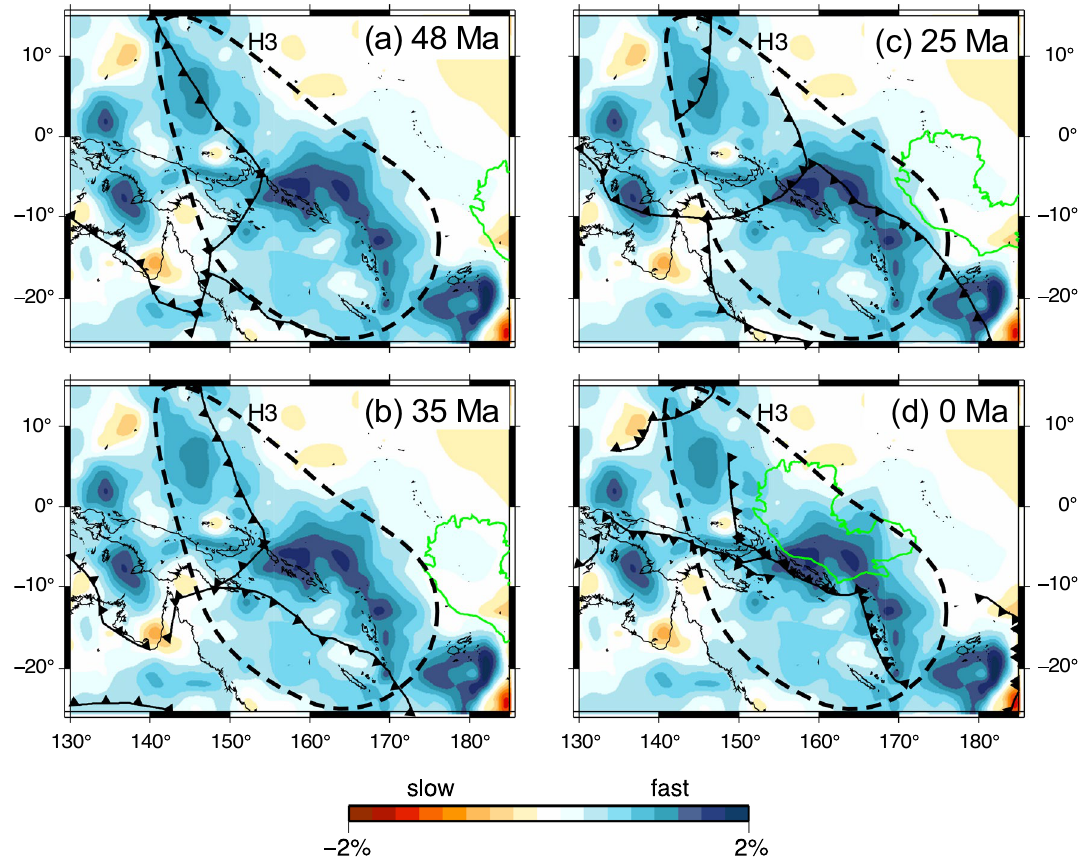
Figure 4. Paleo subduction boundaries and location of the OJP of ( a ) 48 Ma, ( b ) 35 Ma, ( c ) 25 Ma and ( d ) 0 Ma by Seton et al. 16 superimposed on P-wave velocity anomalies at depth of ~ 600 km. The GMT 5.4.5 53 was used to make this